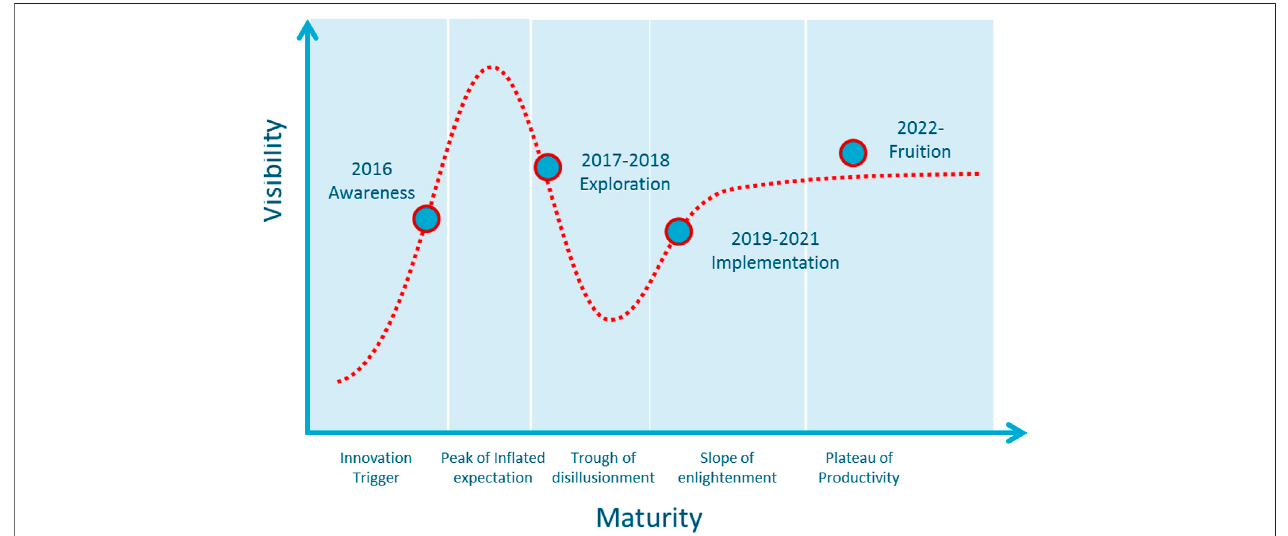
FIGURE 1 | The hype cycle of blockchain in agriculture and food (Source: van Wassenaer et al., 2021).